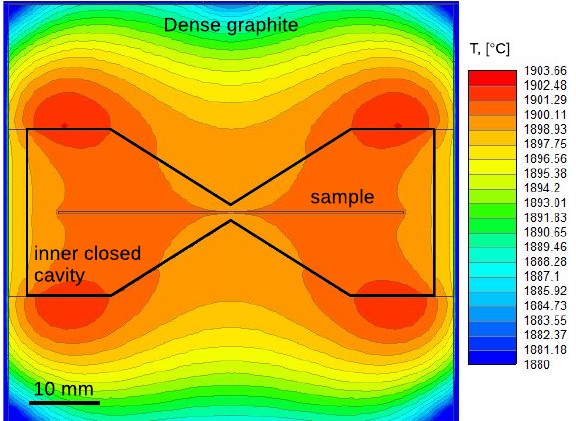
Figure 1. A schematic of the crucible with the distribution of the temperature overplotted. Note that the SiC substrate is placed within a tightly closed inner cavity and it is completely surrounded by